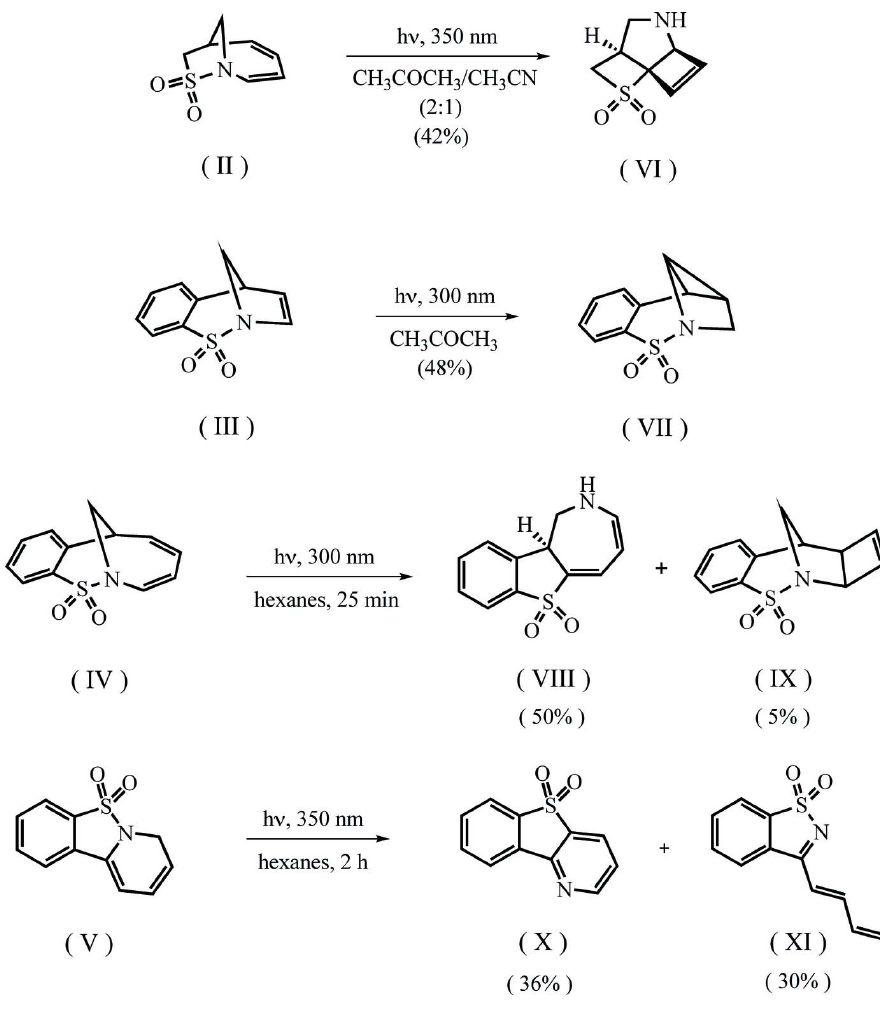
Figure 2 Photochemical reactions for sulfonamides (II—V).